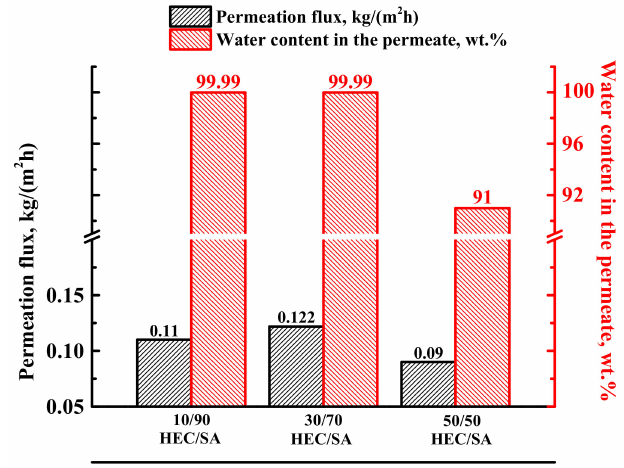
Figure 1. The permeation flux and water content in the permeate of the dense blend HEC/SA membranes in pervaporation separation of the azeotropic water (12 wt.%)—isopropanol (88 wt.%) mixture at 22 ◦ C.